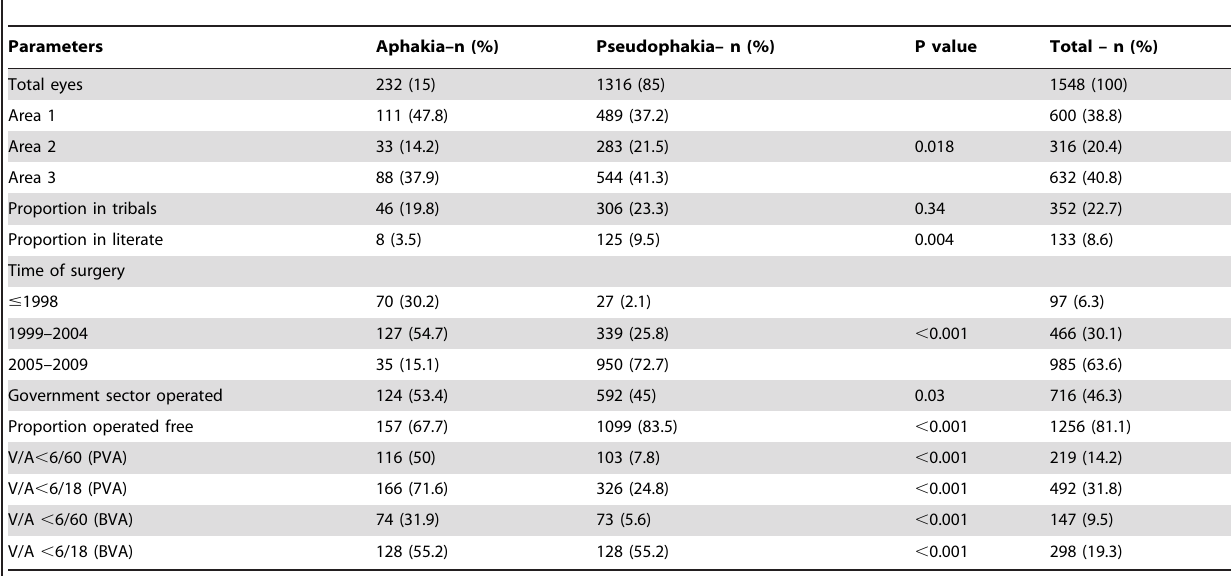
Table 1. Comparison of characteristics of 1548 eyes based on their lens status.